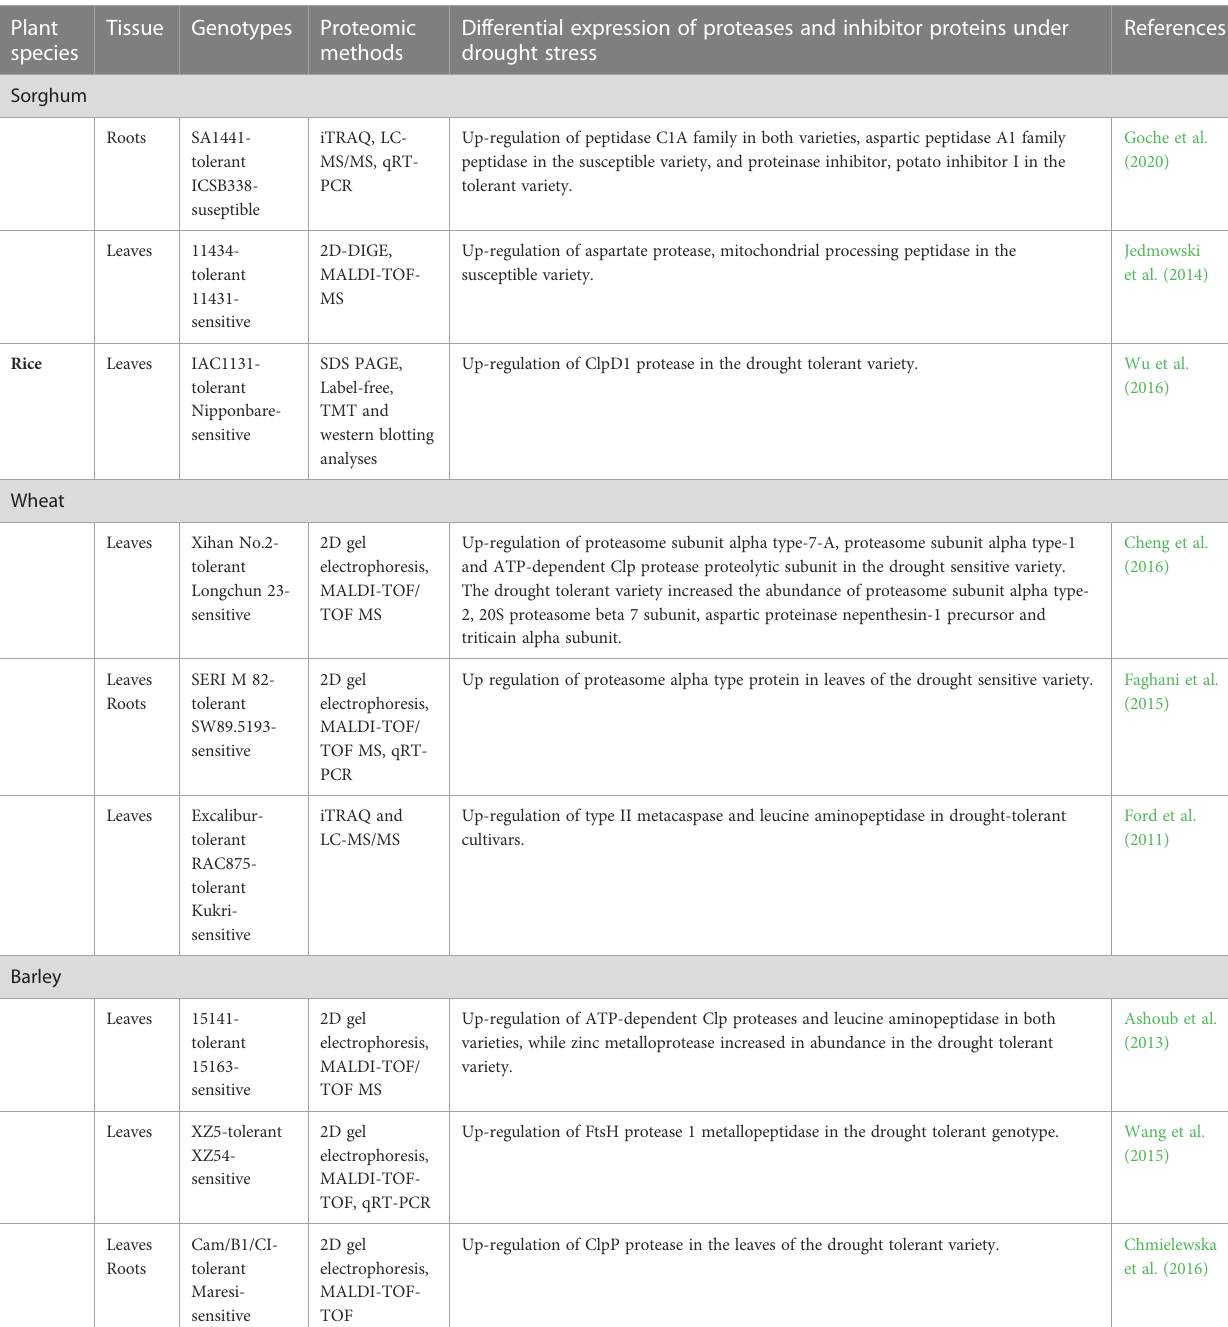
TABLE 3 Studies showing differential accumulation and functional activities of protease and protease inhibitor proteins in plants under drought stress.